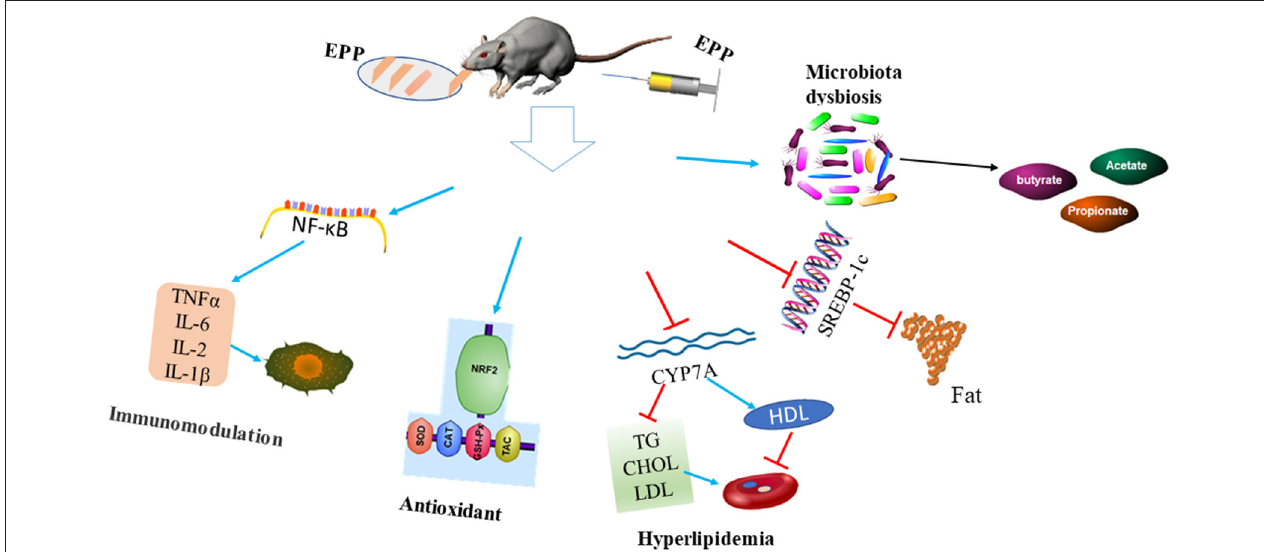
FIGURE 3 | Biological activities and health benefits of E. prolifera polysaccharides. The injection or dietary supplementation of E. prolifera polysaccharides modulate gut microbiota and stimulate short-chain fatty acid production. In addition, it stimulates antioxidant activities, alleviates inflammation, reduced serum TG, CHOL, and LDL levels, and reduces fat accumulation via a different mechanism. EPP: E. prolifera polysaccharide; NF- κ B: Nuclear factor kappa-light-chain-enhancer of activated B cells; IL-2: Interleukin 2; IL-6: Interleukin; IL-10: Interleukin; NRF2: Nuclear factor erythroid 2-related factor 2; SOD: Superoxide dismutase; CAT: Catalase; GSH-Px: Glutathione peroxidase; TAC: Total antioxidant capacity; TG: Triglyceride; CHOL: Cholesterol; LDL: Low-density lipoprotein; HDL: High-density lipoprotein; CYP7A: Cholesterol 7 alpha-hydroxylase; SREBP1c: Sterol regulatory element-binding